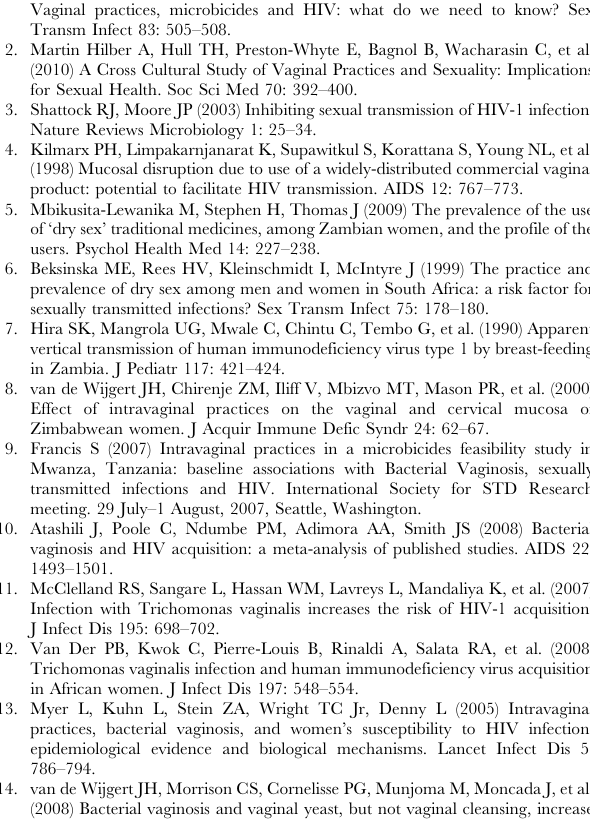
Table S2 Studies reporting associations between intravaginal practices and incident HIV infection (objective 1). BV, bacterial vaginosis; CT, Chlamydia trachomatis ; HSV2, herpes simplex virus type 2; NG, Neisseria gonorrhoeae ; NR, not reported; wy, woman years of follow up; WBC, white blood cells.